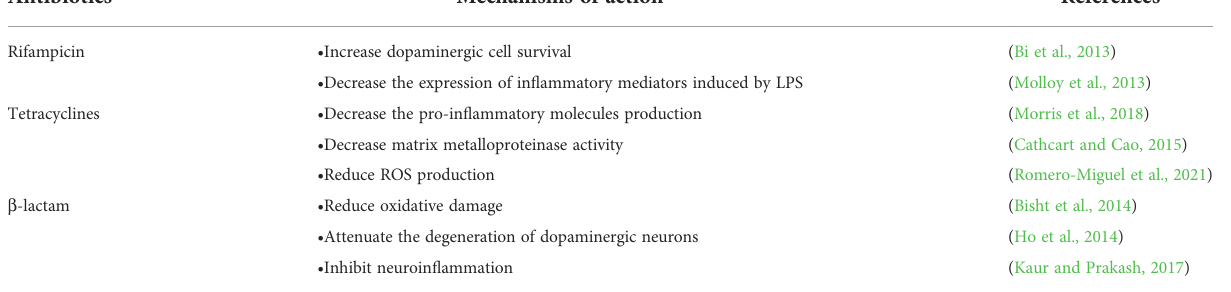
TABLE 1 The protective mechanisms of antibiotics on PD. Antibiotics Mechanisms of